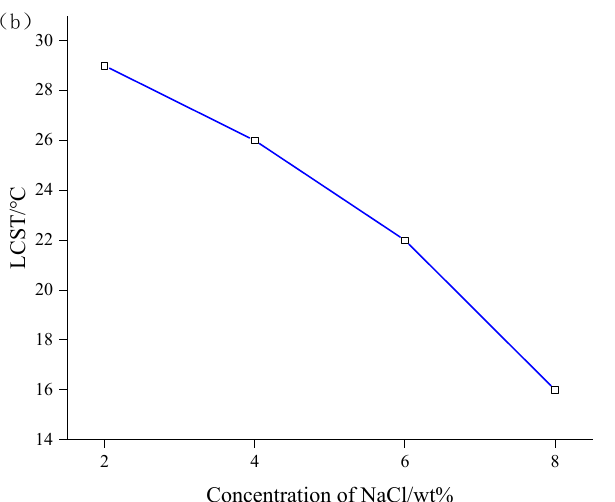
Figure 9. Effects of the NaCl concentration (wt%) on turbidity change with temperature ( a ) and LCST ( b ) of PNBAM aqueous solution.